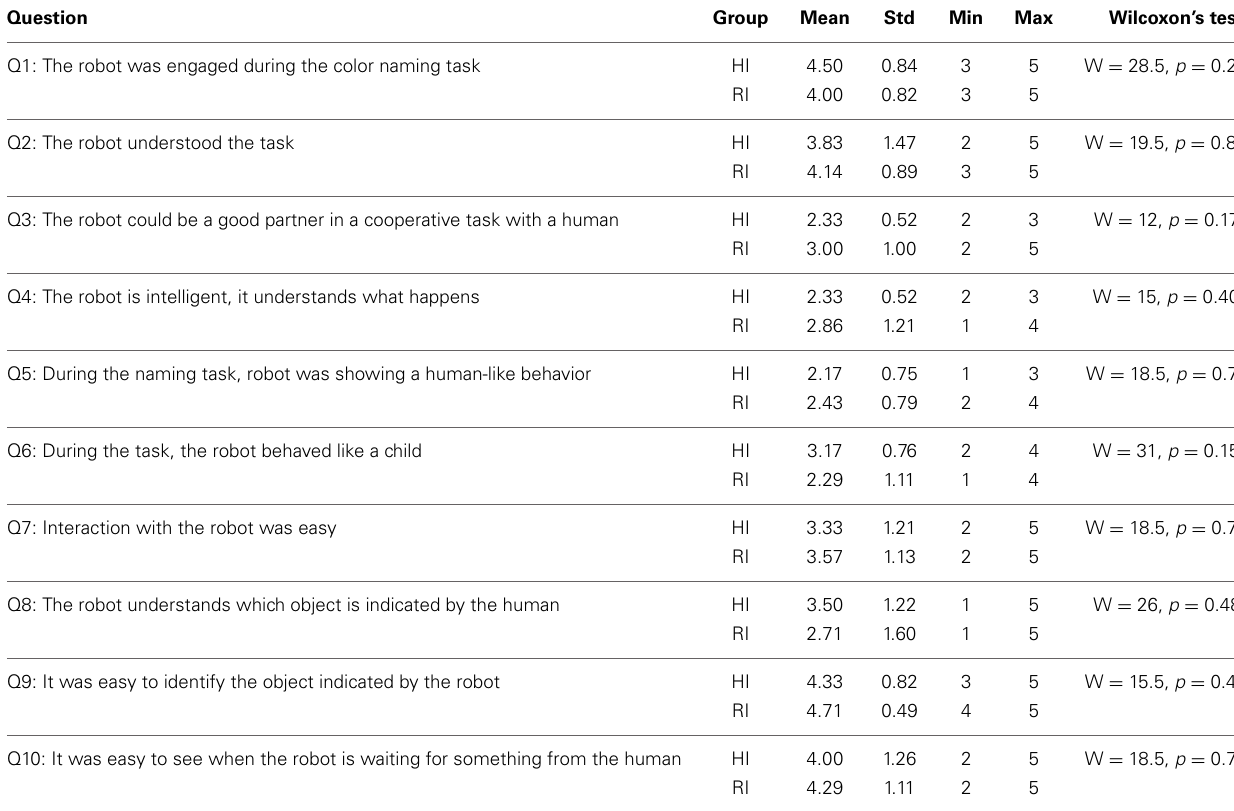
Table 4 | Post-experiment questionnaire for